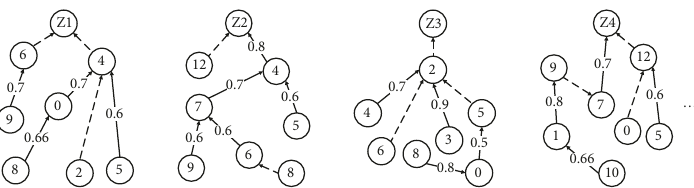
Figure 1: Several hypergraphs constructed from 𝑔 󸀠 (dotted line represents there is a path from a node to another and the path passes through other nodes; real line represents a directed